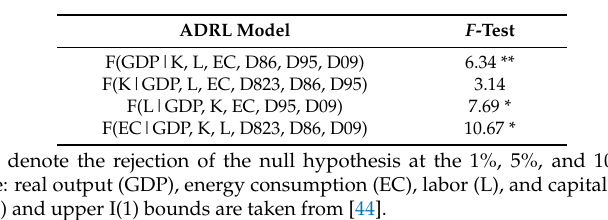
Table 4. ADRL co-integration analysis at the aggregated level.